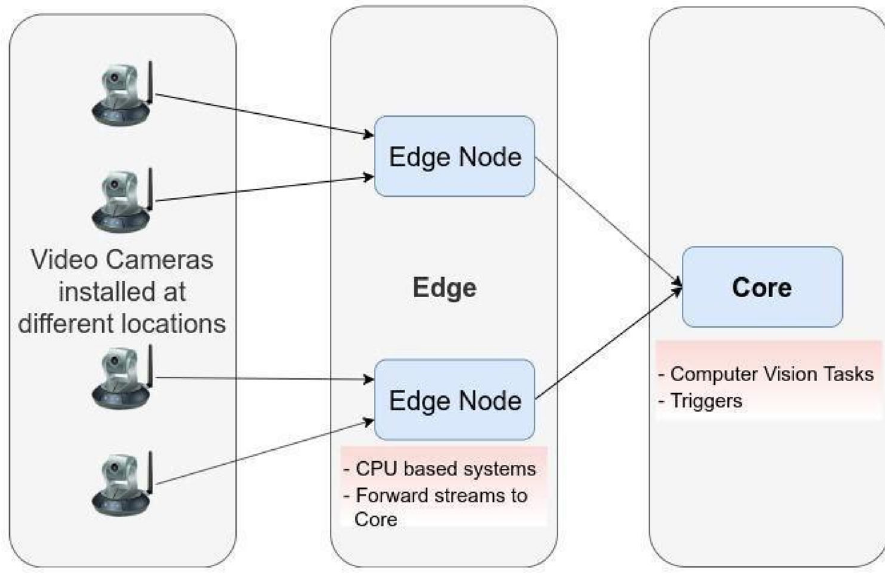
Fig. 1 Generic video stream analytics